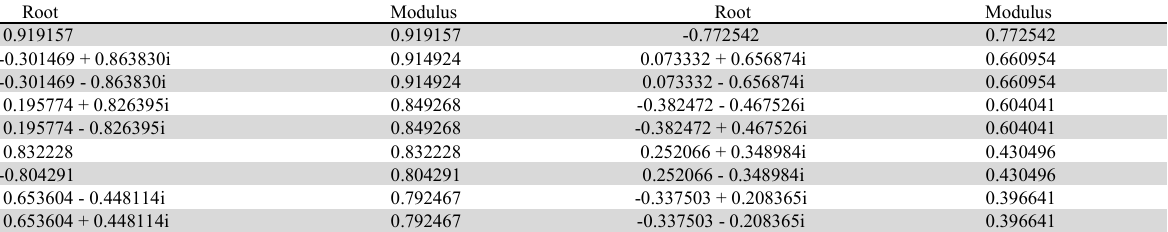
Testing the stability of the model